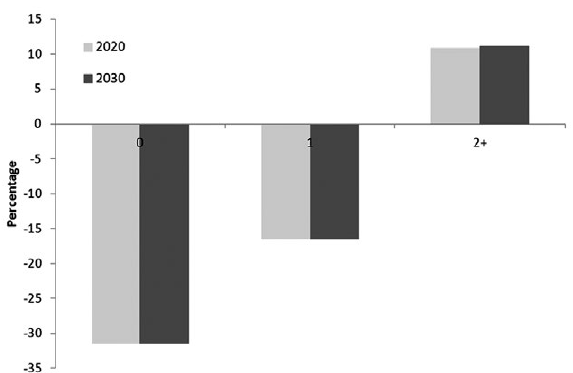
Fig. 5. – Proportional change in age composition of DPS catch in 2020 and 2030 in Scenario II (trawl net with grid and recruitment as in the status quo) when compared with the status quo Scenario I (traditional trawl